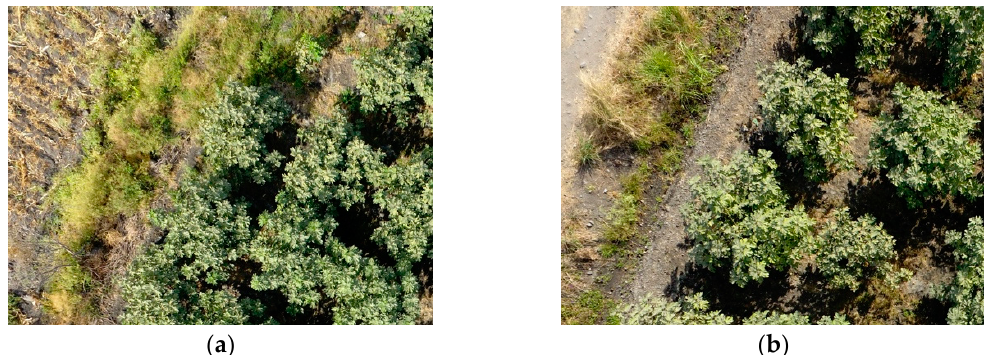
Figure 11. Images used to extract the test patches in the case where the lowest accuracy was obtained: ( a ) image 10_A and ( b ) image 101_A.